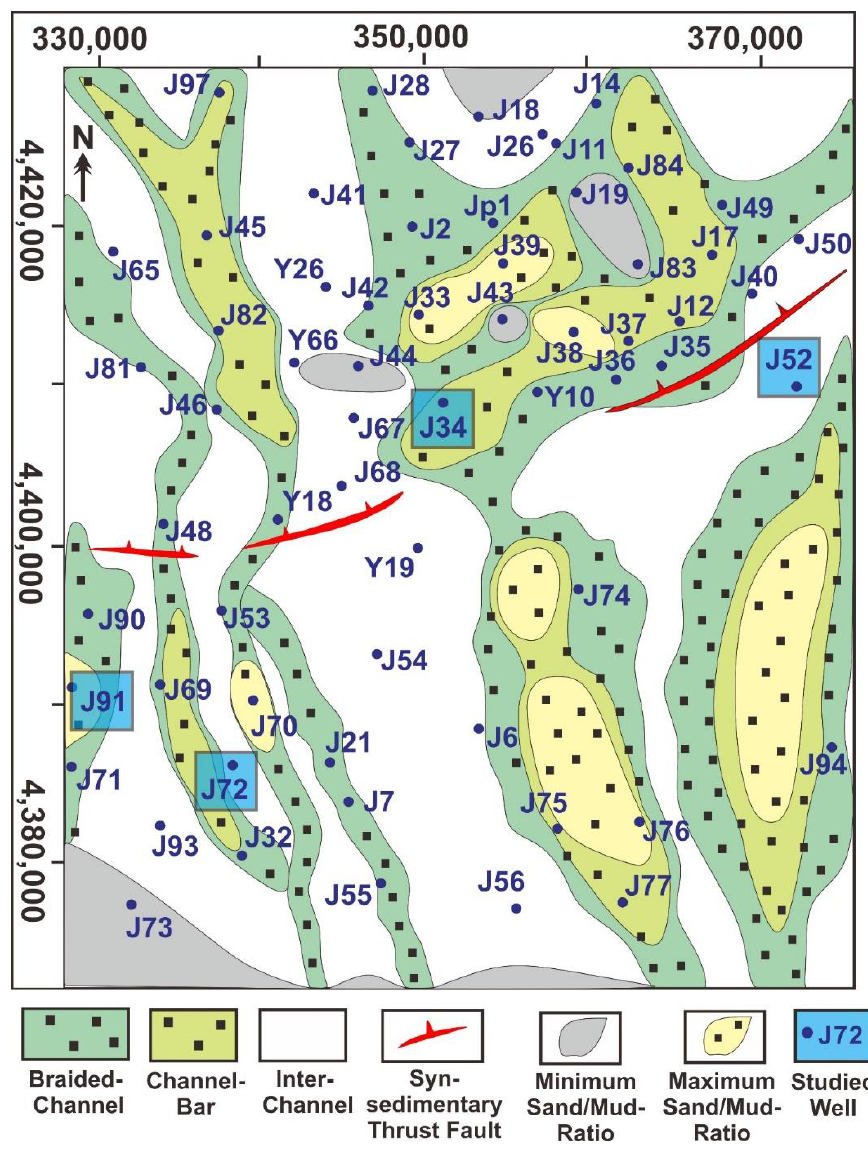
Figure 14. Proposed depositional facies map for reservoir quality prediction showcasing the depo- sitional framework and sedimentary facies distribution for the member-1 of the LSF within the Hangjinqi area.